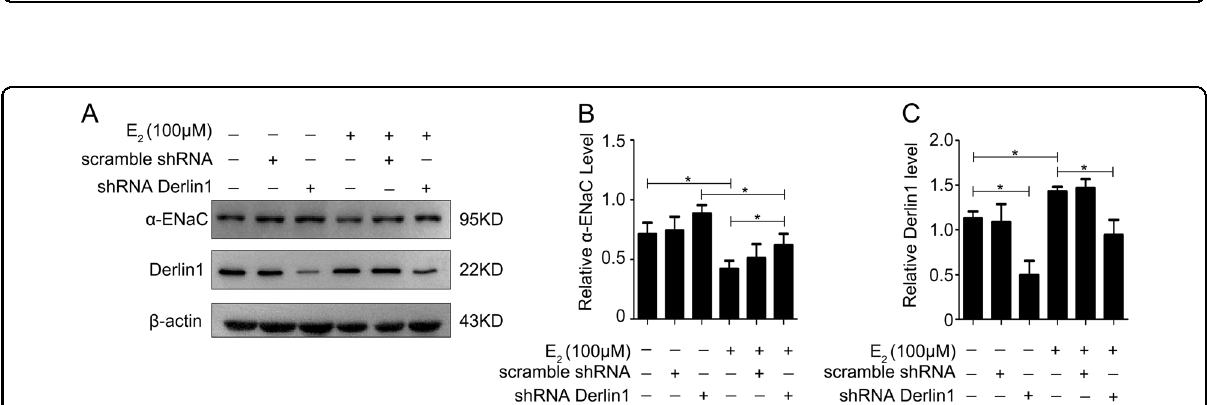
Fig. 7 Knockdown of derlin-1 signi fi cantly reversed the E 2 -induced decrease in α -ENaC. a Downregulation of derlin-1 by shRNA-derlin-1 transfection in mpkCCDc14 cells signi fi cantly reversed the E 2 -induced decrease in α -ENaC. b Quanti fi cation of the α -ENaC expression shown in ( a ) normalized to β -actin expression. c Quanti fi cation of the derlin-1 expression shown in ( a ) normalized to β -actin expression. The bars are the means ± SE values from three independent experiments. * P <